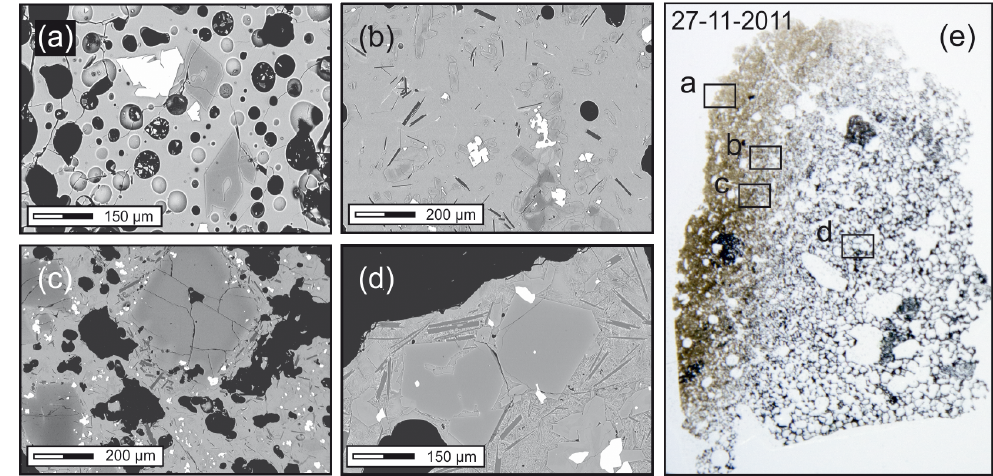
Figure 7. Scanning electron microscope (SEM) backscattered and optical microscope images representative of groundmass textures ob- served in floating scoriaceous fragments and of lava balloons. (a) External portion originally in contact with seawater showing a completely glassy groundmass. (b-c) intermediate portion of the external crust with abundant microphenocrysts of olivine, clinopyroxene, spinel and plagioclase and skeletal microlites mostly of clinopyroxene. (d) Groundmass with intersertal texture made of microlites of clinopyroxene, spinels and plagioclase. (e) Positions where a-d images have been